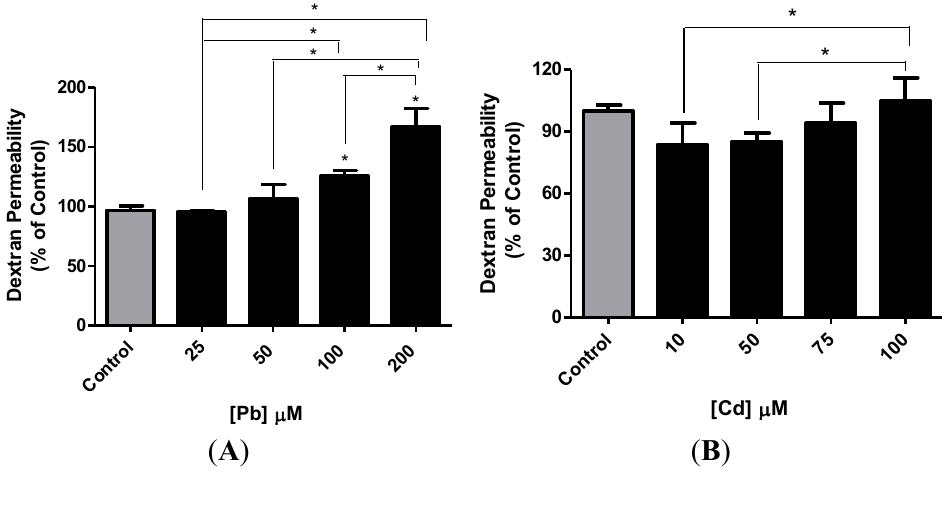
Figure 6. Effects of ( A ) Pb and ( B ) Cd on FITC-Dextran permeability in hCMEC/D3 cells. hCMEC/D3 cells were seeded onto a collagen-coated insert with a pore size of 0.4 μm at a density of 15 × 10 3 cells/well and allowed to grow until a monolayer was formed. The cell monolayer was then treated with different concentrations of Pb (25–200 µM) and Cd (10–100 µM) for 48 h and 24 h, respectively. Fluorescence was read with a 485 nm and 530 nm filter set. All experiments were performed in triplicates, and the values reported are mean ± SD ( * over the test column represents p < 0.05 compared to the control, and on the linking lines represents p < 0.05 between the two test